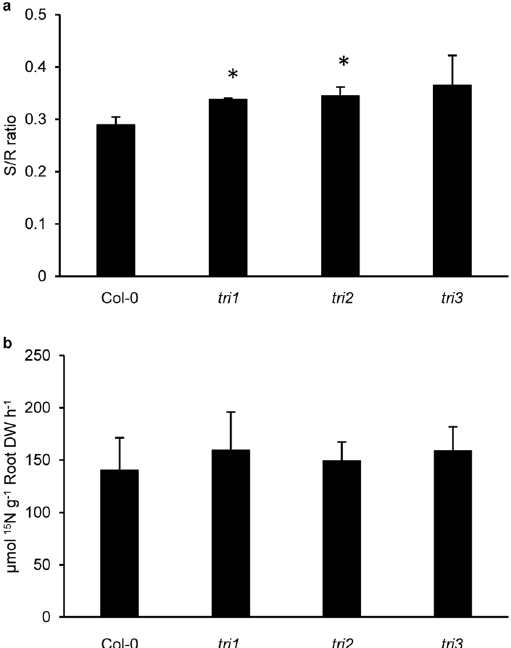
Figure 4. Root-to-shoot nitrate transport enhanced in the triple mutant plants npf5.11 npf5.12 npf5.16 . Plants were grown in hydroponics for 28 days and treated with 2.25 mM K 15 NO 3 for 30 min. 15 N contents in shoots and roots were analyzed. 15 N concentration ratio between shoots and roots (S/R ratio, a ) and root uptake activity ( b ) were determined. Values are means ± SD, n = 3. Asterisks indicate difference between wild type and triple mutant lines at P < 0.05 ( * ) by Student’s t